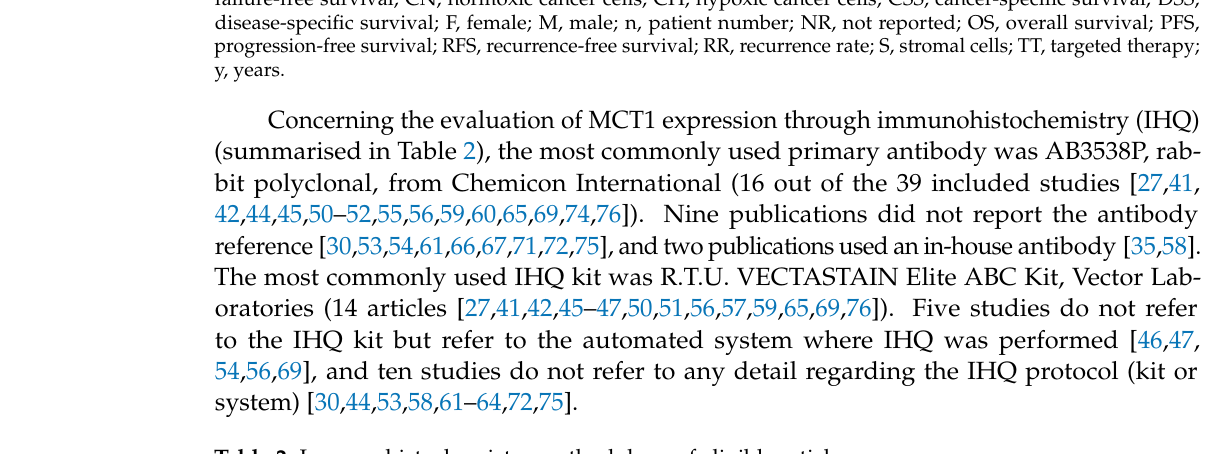
Table 2. Immunohistochemistry methodology of eligible